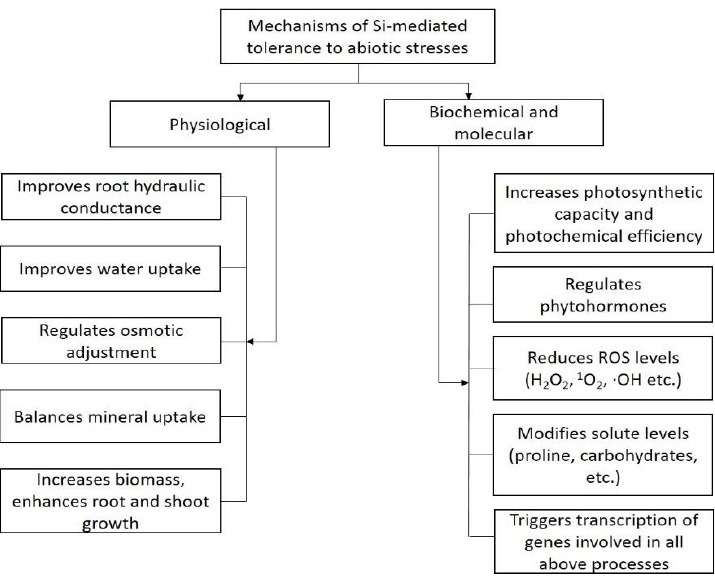
Figure 2. Mechanisms of Si mediated tolerance to abiotic